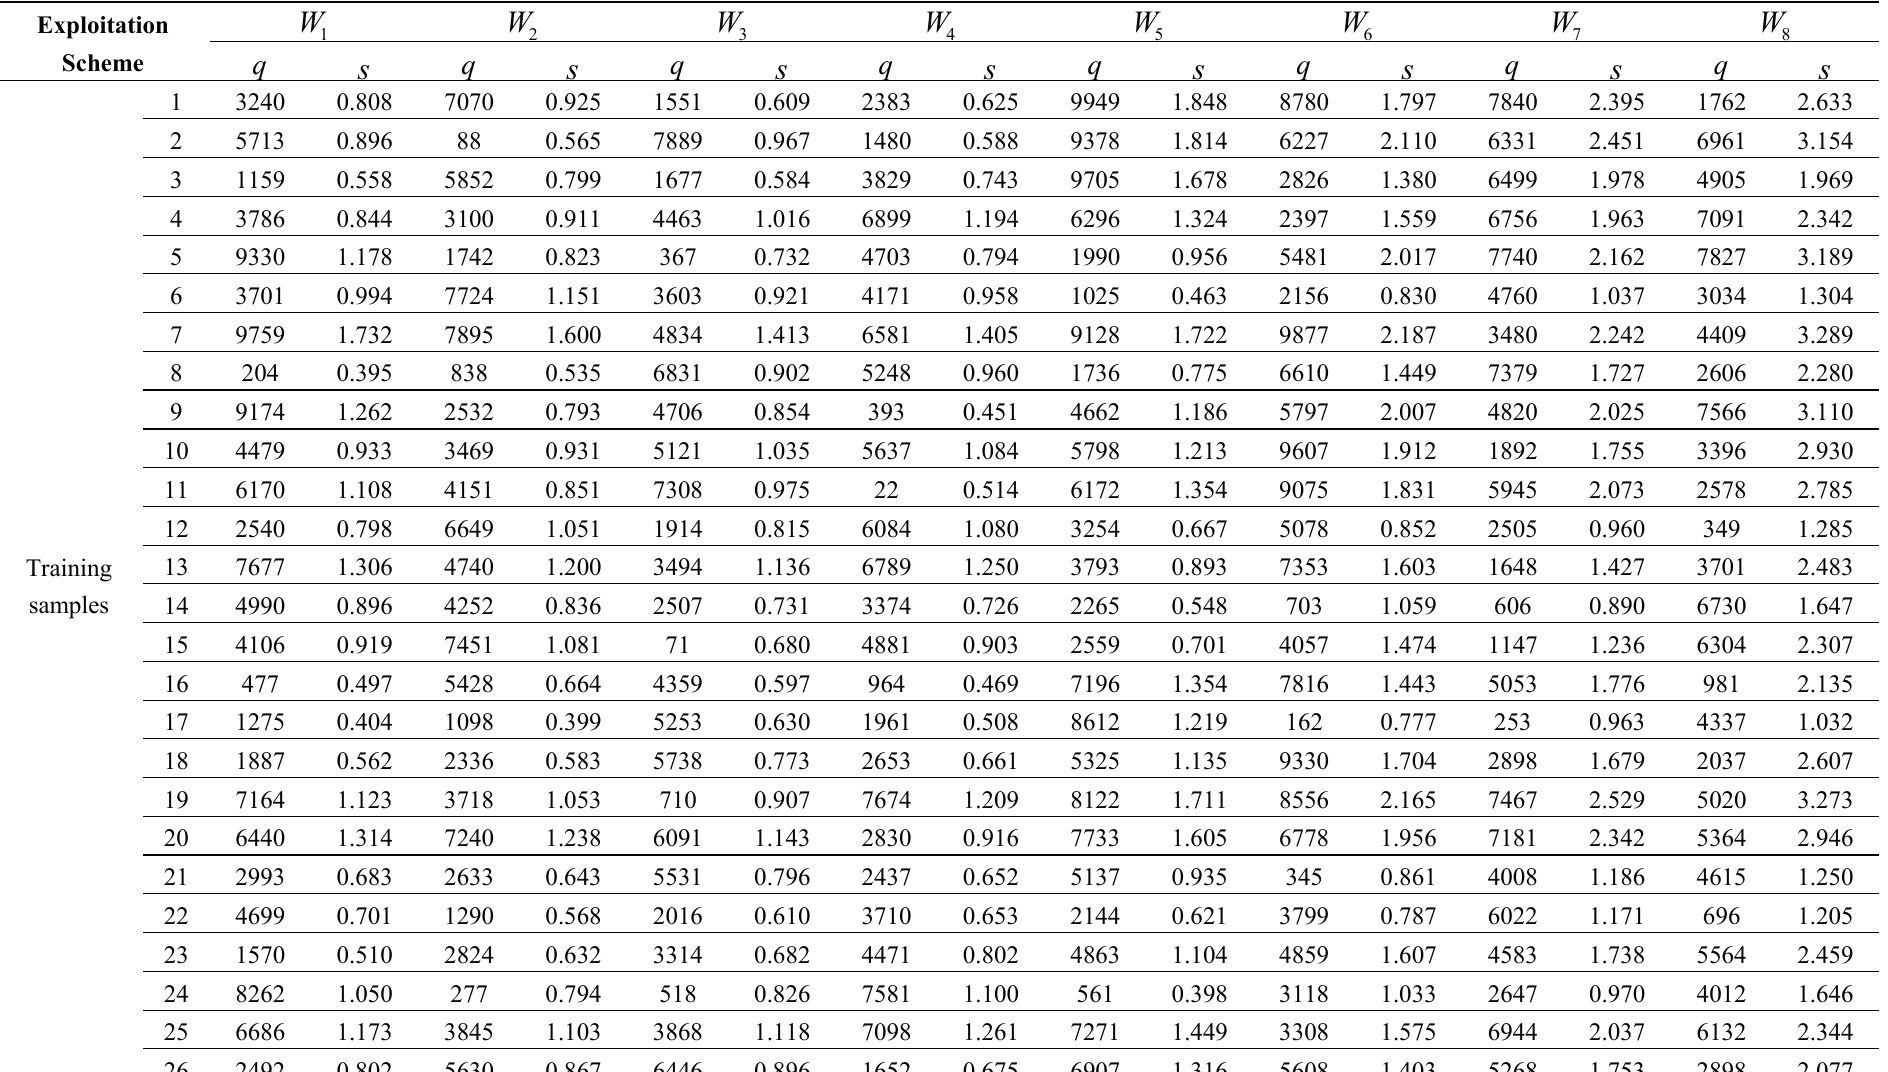
Table 2. Training and validation samples of surrogate model ( q : m 3 /d, s : m).